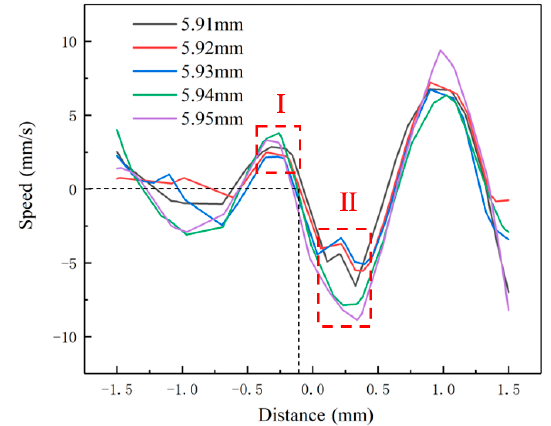
Figure 12. Flow velocity curves of plastic metal at the root of joint with different pin lengths (1000 rpm, 120 mm/min). ( a ) 0.05 mm per step from 5.8 mm to 5.95 mm; ( b ) 0.01 mm per step from 5.91 mm to 5.95 mm.